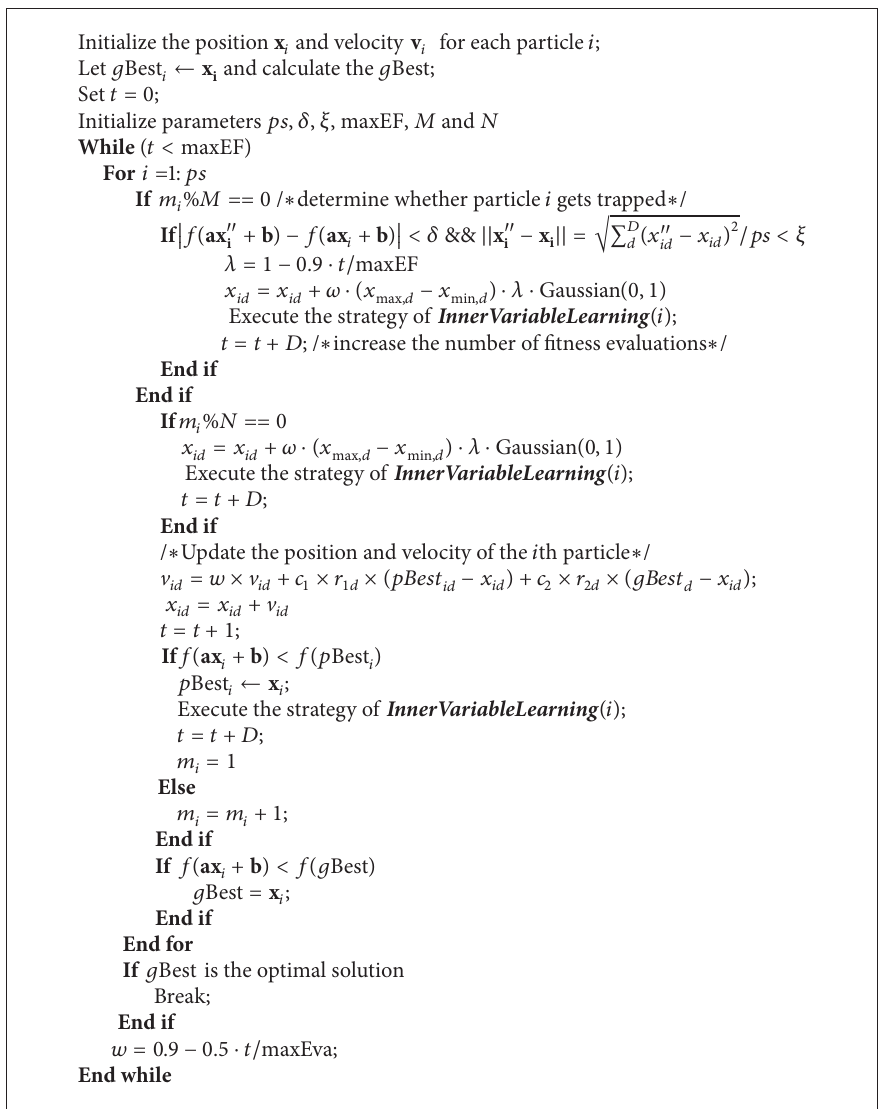
Algorithm 2: Procedure of PSO-IVL.